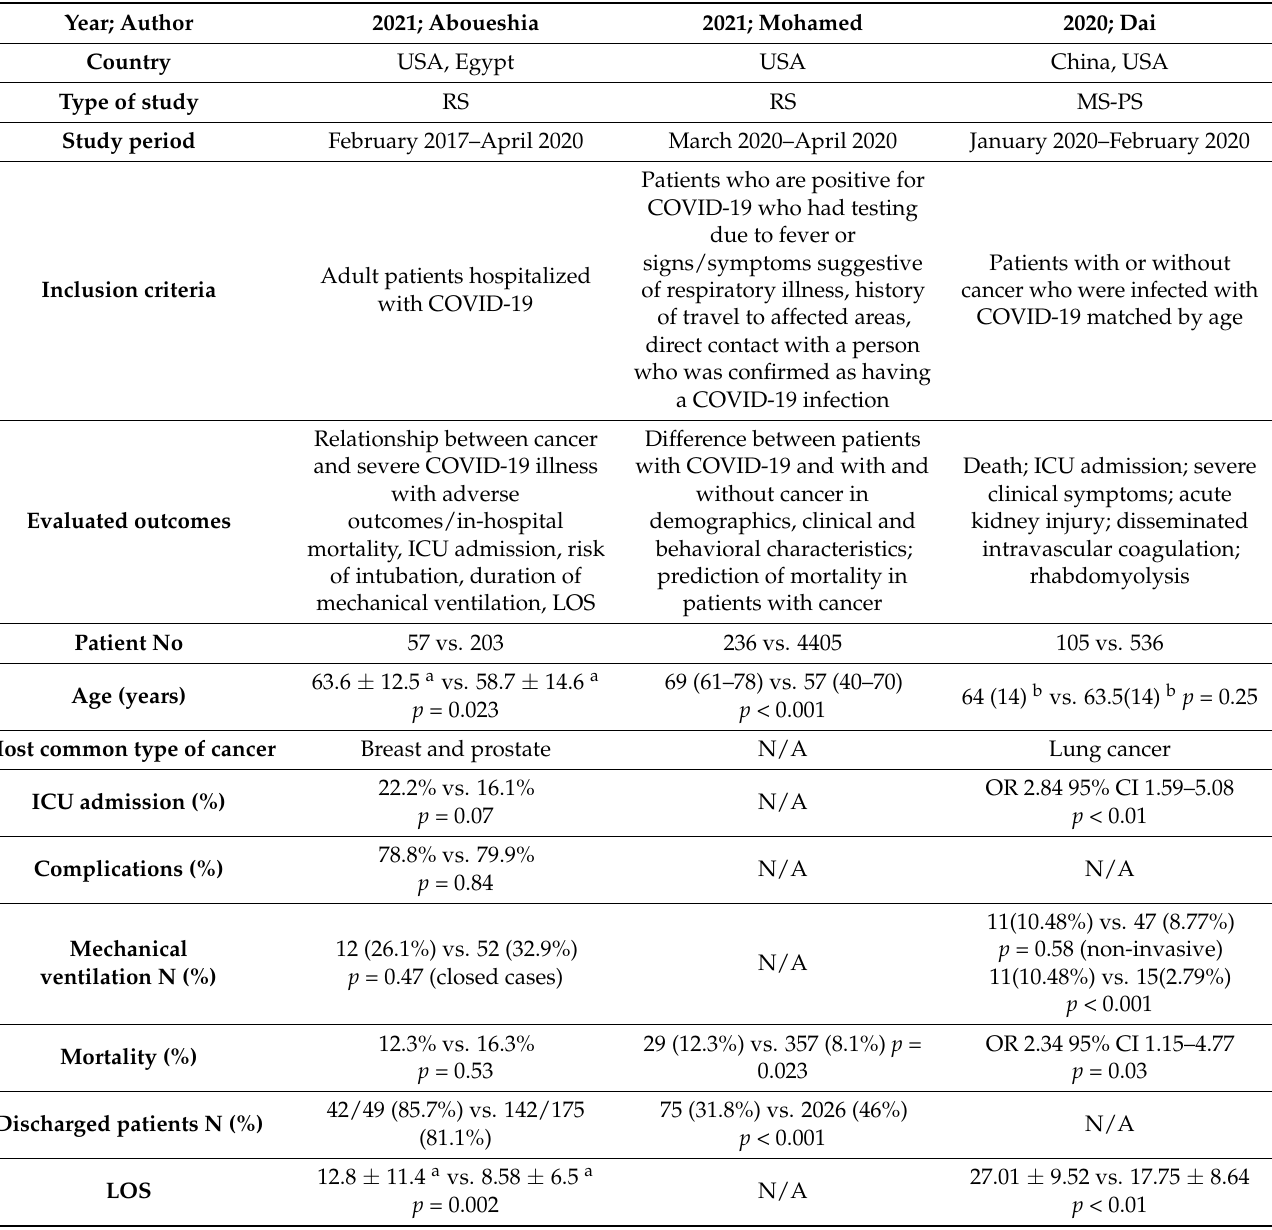
Table 1. Studies reporting characteristics and outcomes of patients with COVID-19 with malignancy versus without